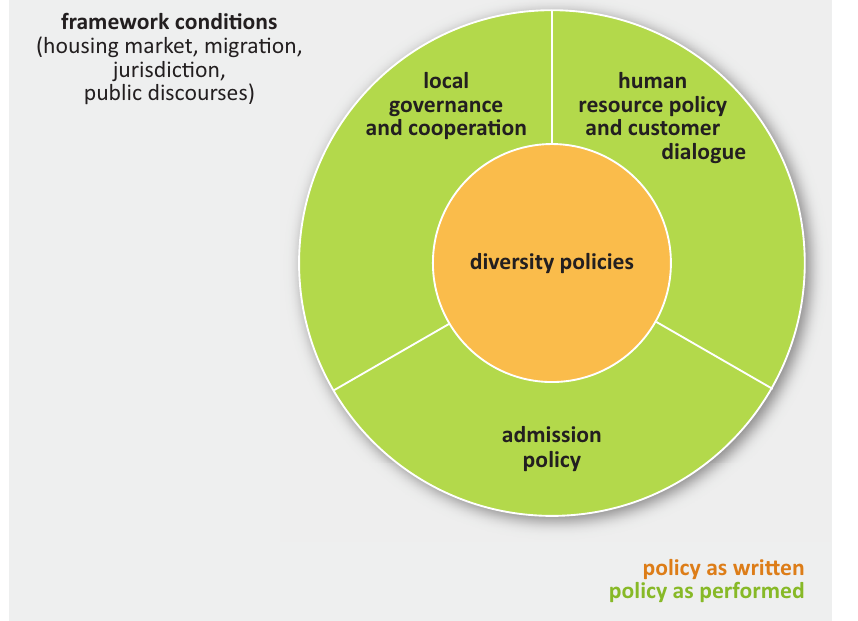
Figure 1. ‘Policy as written’ and ‘policy as performed’ in the field of